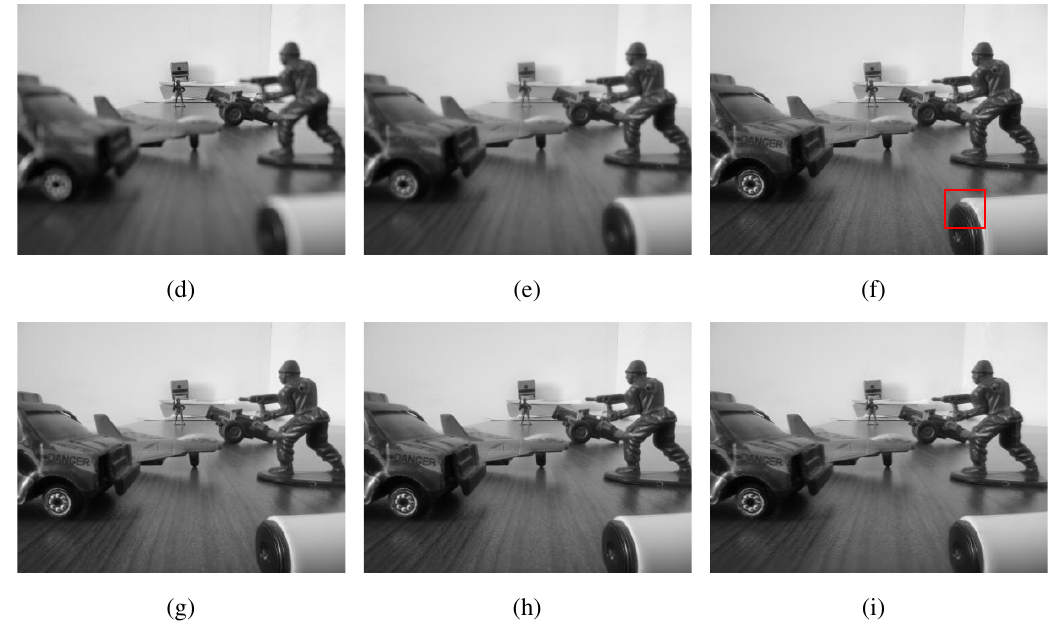
Figure 10. Multi-focus image fusion results for Dataset 2. ( a ) Image 1; ( b ) Image 2; ( c ) Image 3; ( d ) Image 4; ( e ) PCA; ( f ) DWT; ( g ) NCT-S; ( h ) NCT-N; ( i ) MEMD.